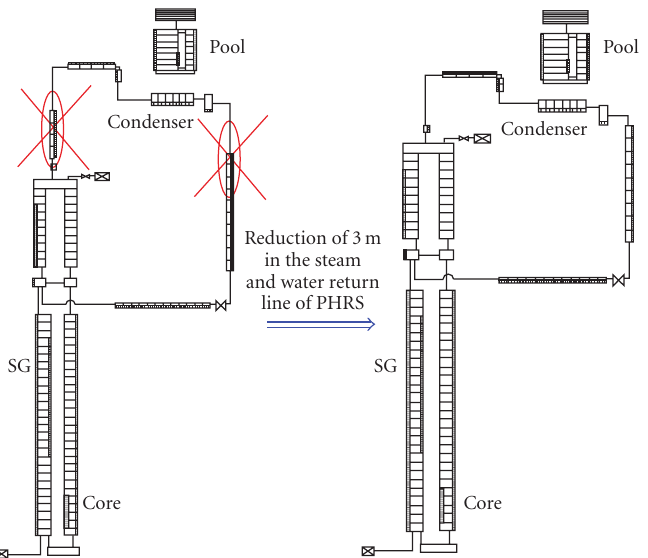
Figure 14: Lay-out modification: scope calculation.